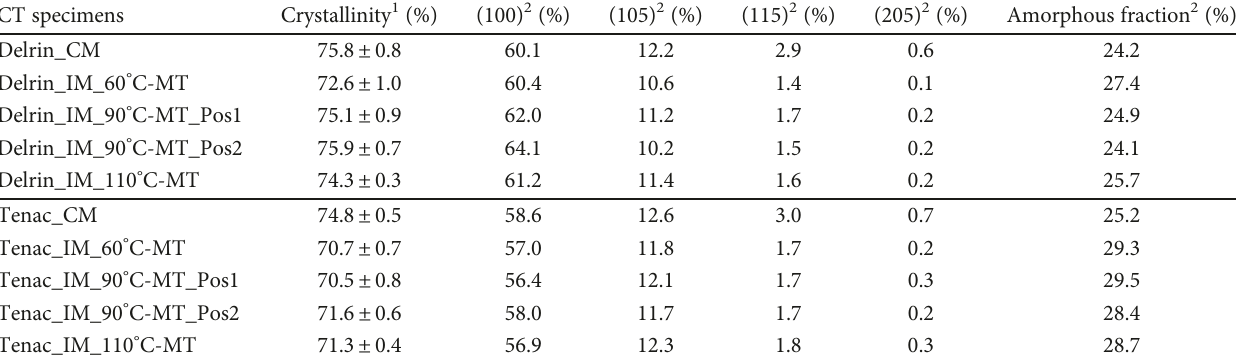
Table 7: WAXD measurements of the CT specimens analyzed for the contribution of the di ff erent di ff raction peaks to the total crystallinity. CT